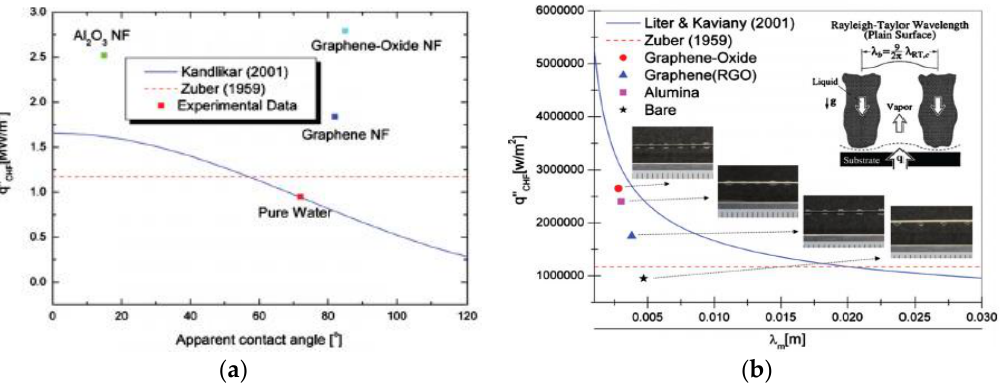
Figure 7. CHF phenomena and comparisons between models and experimental data. ( a ) Effects of a surface wettability (Kandlikar’s model with contact angle). ( b ) Effects of a geometrically determined critical instability wavelength [111].